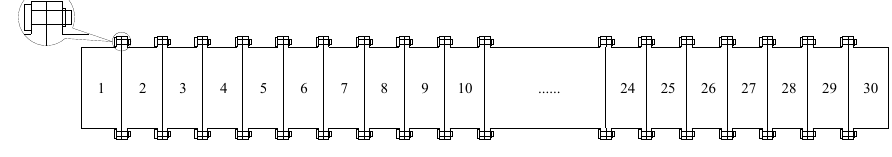
Figure 7. Number of aluminum pipes. Sensors 2018 , 18 , x